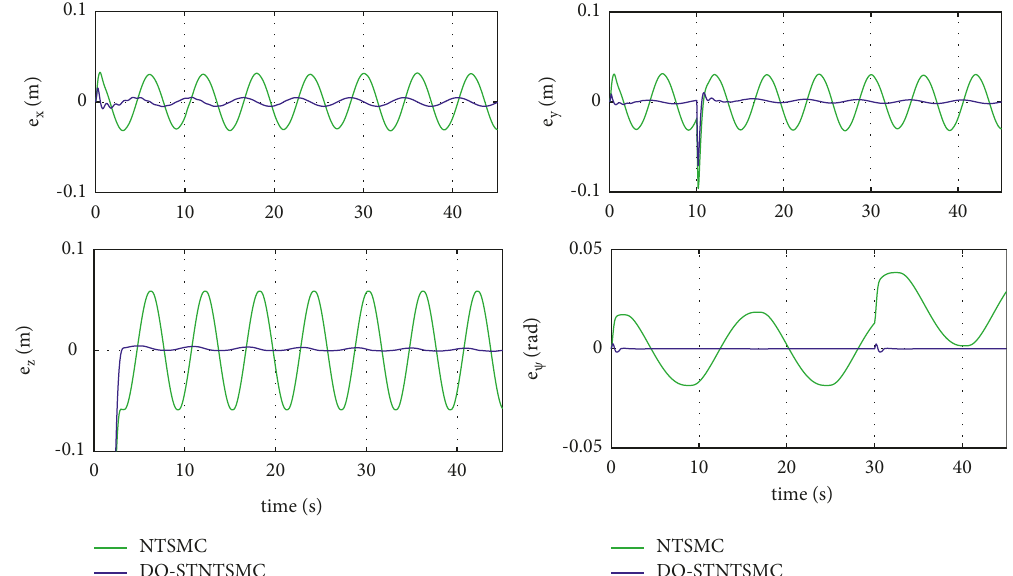
Figure 12: Evolution of the tracking errors in the second